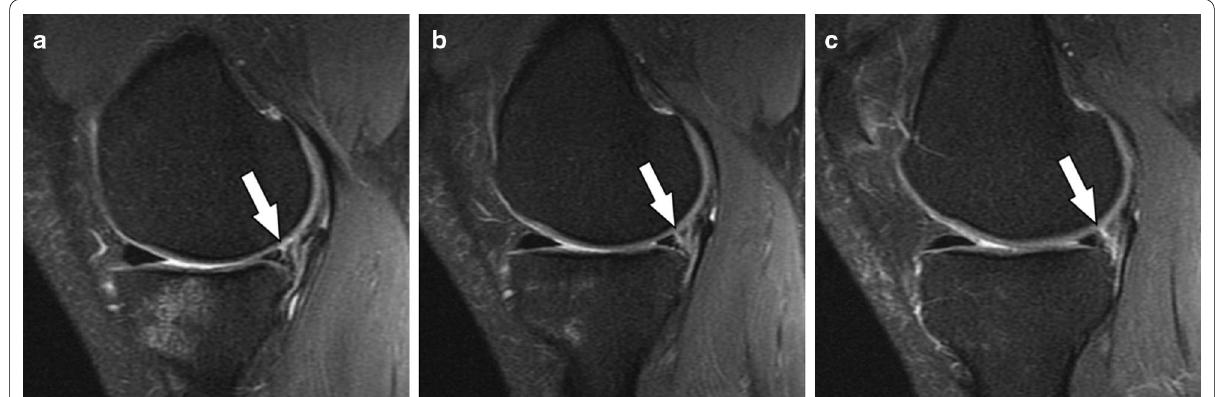
Fig. 5 Type 2 meniscal ramp lesion MRI Case. Sequential sagittal T2‑weighted fat‑suppressed MR images show peripheral partial tear of posterior horn of medial meniscus (arrows) affecting the femoral articular surface, along with meniscocapsular ligament